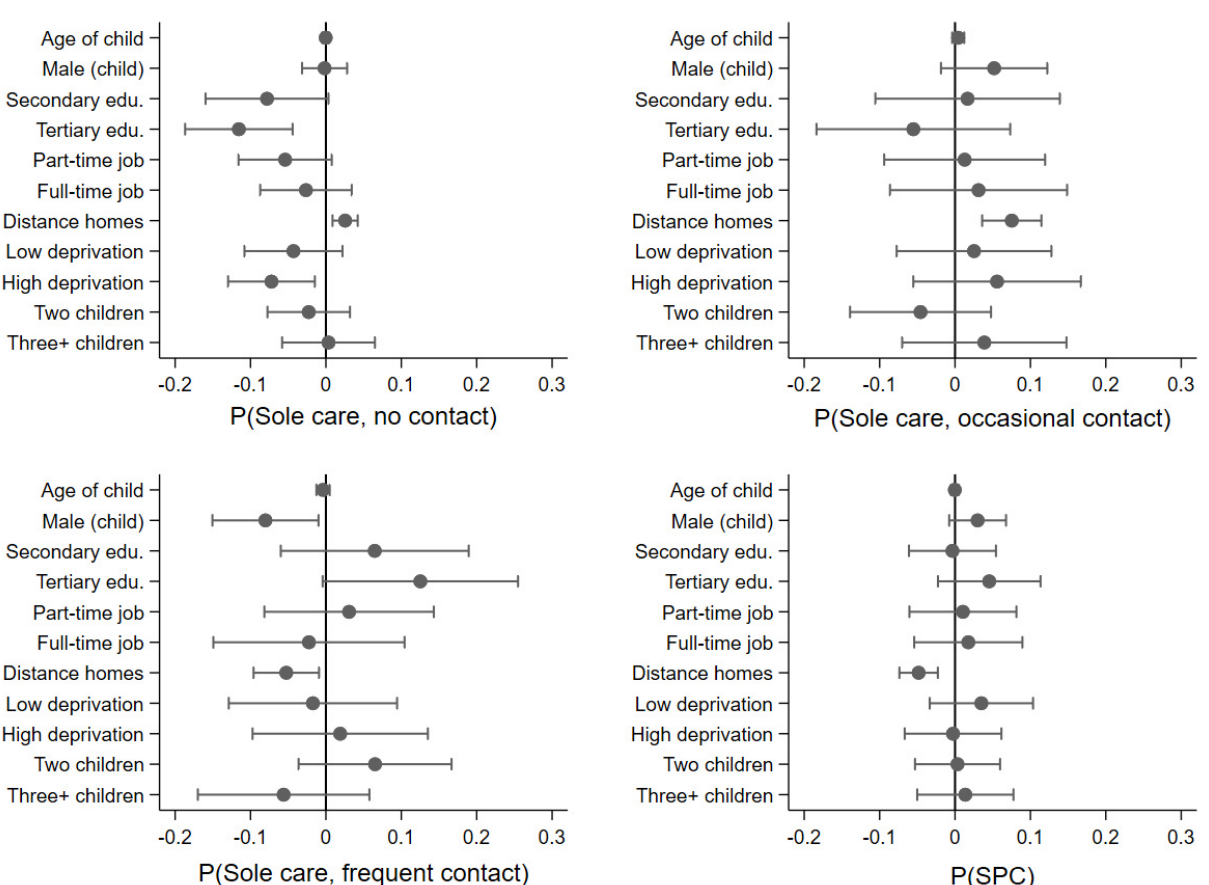
Figure 1. Predicted probabilities of belonging to each post-separation physical custody arrangement based on socio-demographic and socio-economic predictors. Reference categories are: Female; Primary levels of education; Not employed; No economic deprivation; One child in the household.